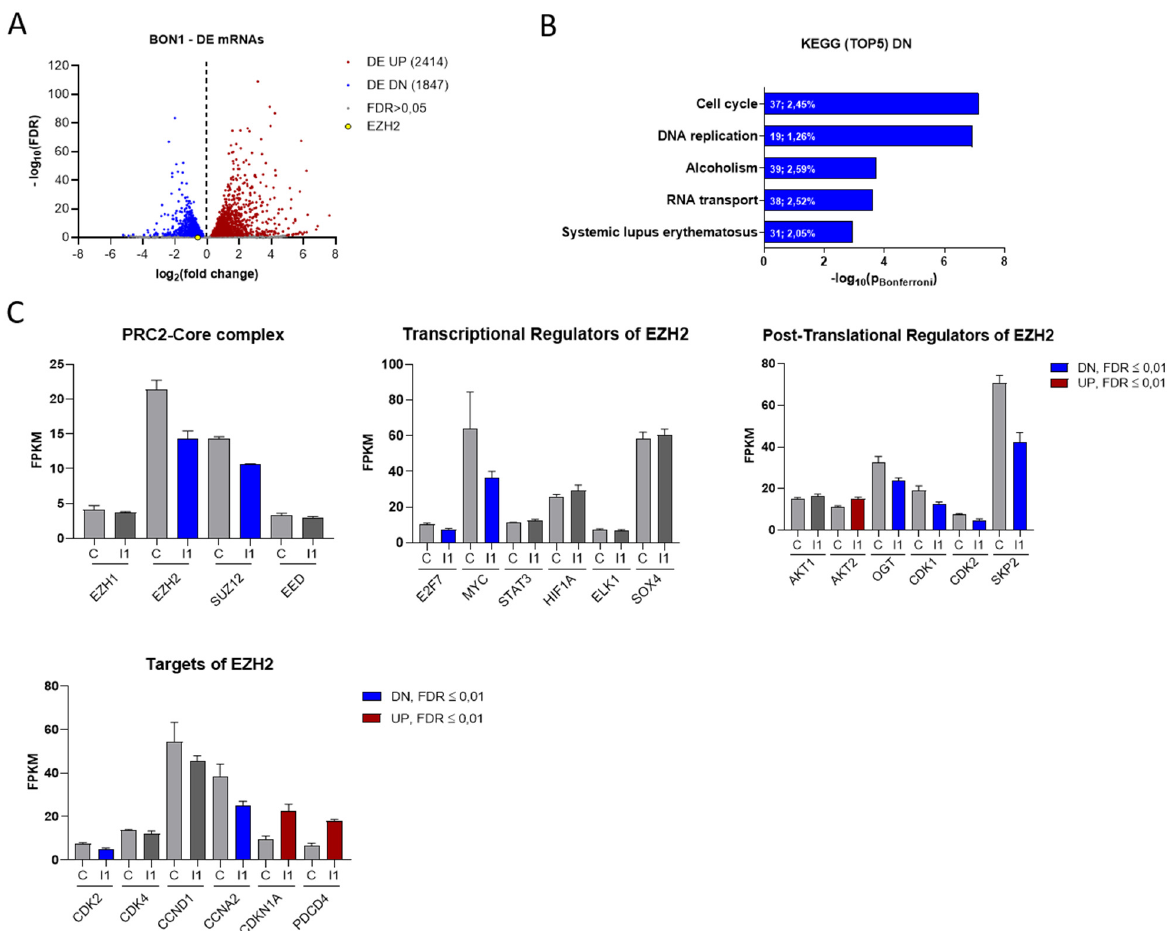
Figure 3. IGF2BP1 knockdown affects the transcriptional landscape of NEN cells. ( A ) Volcano plots of differentially expressed (DE) genes (threshold: FDR < 0.05) determined by RNA-seq in BON1 cells upon IGF2BP1 knockdown compared to siC transfected cells after 72 h. ( B ) KEGG- pathway analysis of mRNAs downregulated upon IGF2BP1 knockdown in BON1 cells (threshold: FDR < 0.01). Path- ways are ranked by Bonferroni-corrected significance. First number indicates counts mapped to the respective pathway and second number gives percentage of these counts related to total pathway counts. ( C ) Expression of potential PRC2 components as well as EZH2 transcriptional, post-transla- tional regulators and targets in BON1 cells after IGF2BP1 (I1) knockdown compared to siC ( C ) eval- uated by RNA-seq. 3.4. EZH2 Is Regulated by IGF2BP1 in NEN Cells To investigate the impact of alterations of the PRC2 core components in NEN cells in more detail, we analyzed the potential regulatory role of IGF2BP1 on EZH2 and SUZ12 expression. After knock-down of IGF2BP1, EZH2 protein expression was reduced in all three cell lines (Figure 4A). Previous studies have described the transcription factor c-Myc also regulating EZH2 expression in various cancers, as well as in embryonic stem cells [38,44–46]. Likewise, c-Myc mRNA is stabilized by IGF2BP1 in complex with other RNA binding proteins [25]. Following knock-down of IGF2BP1, c-Myc protein levels decreased in BON1 and Colo320 cells, but were not altered in NCIH727 cells (Figure 4A). The con- sistent regulation of EZH2 but inconsistent regulation of c-Myc upon IGF2BP1 knock- down in NEN cell lines raises the possibility that EZH2 expression may also be regulated by direct interaction with IGF2BP1 independently of c-Myc. To further investigate the reg- ulation of EZH2 by IGF2BP1 in NEN cells we analyzed the mRNA binding capacity by